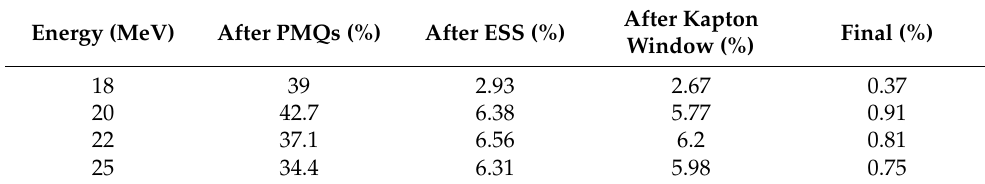
Table 5. Transmission efficiency values for different energy configurations and at different points along the ELIMED beamline. Energy (MeV) After PMQs (%) After ESS (%)